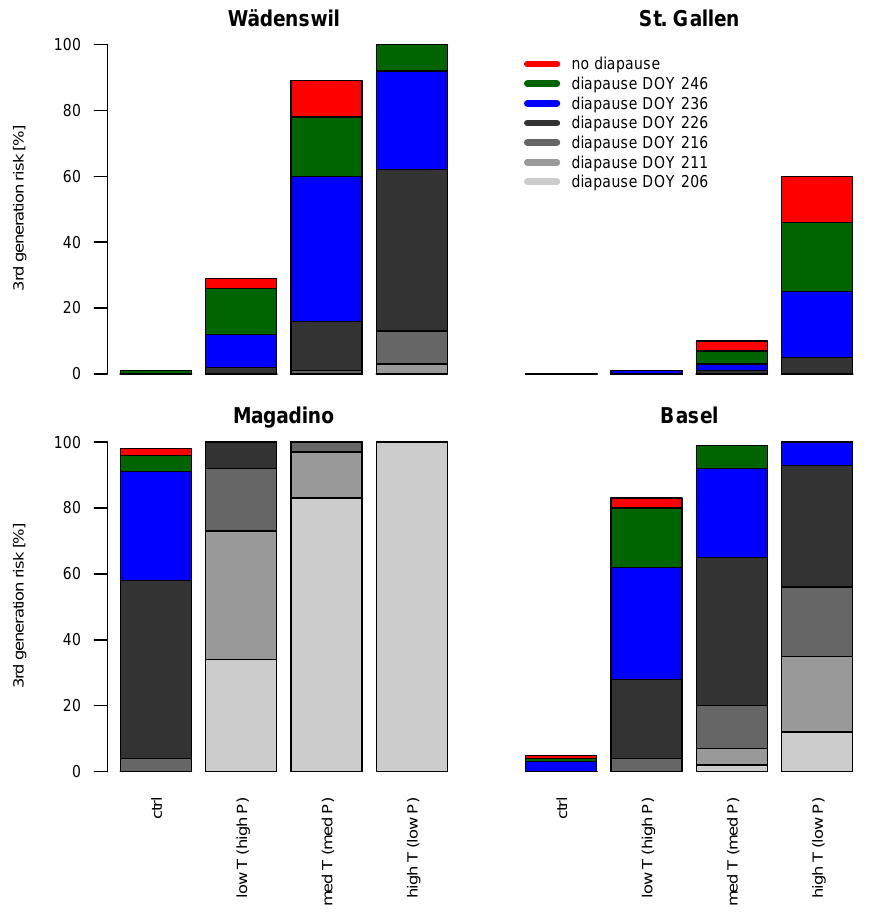
Fig. 7. Sensitivity of the 3rd generation larvae risk on the shift of the day-length signal for diapause induction in today’s (“ctrl”) and future climate (i.e. the three considered combinations of temperature and precipitation change signals, see Sect. 2.1). The actual risks for today’s day-length signal (DOY 206) and for shifts of this signal up to 40 days (DOY 246) are shown. As a reference, also the potential risk for no diapause induction (representing the potential risk as derived from the indicative temperature sums, Table 2) is